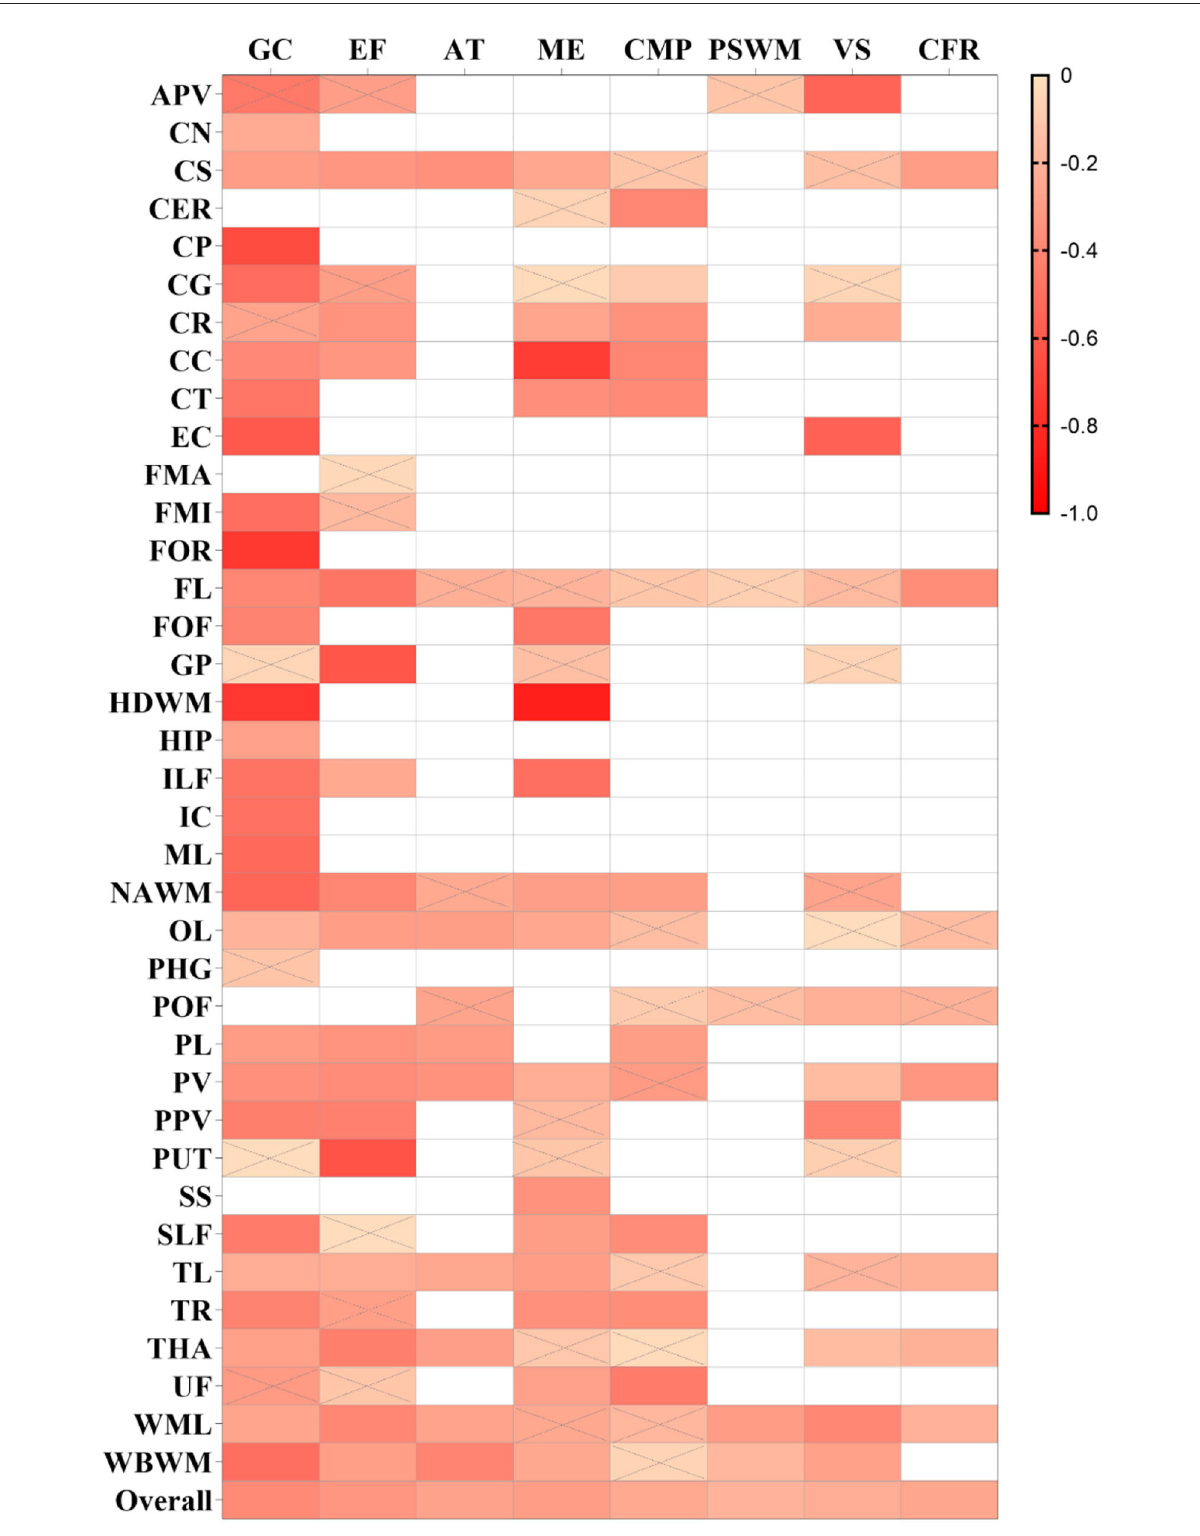
FIGURE5 Summary correlation coefficients between different cognitive domains and mean diffusivity/apparent diffusion coefficient (MD/ADC) in varying regions with color scales. The smaller r values of squares are displayed in a brighter color. The others are the same as